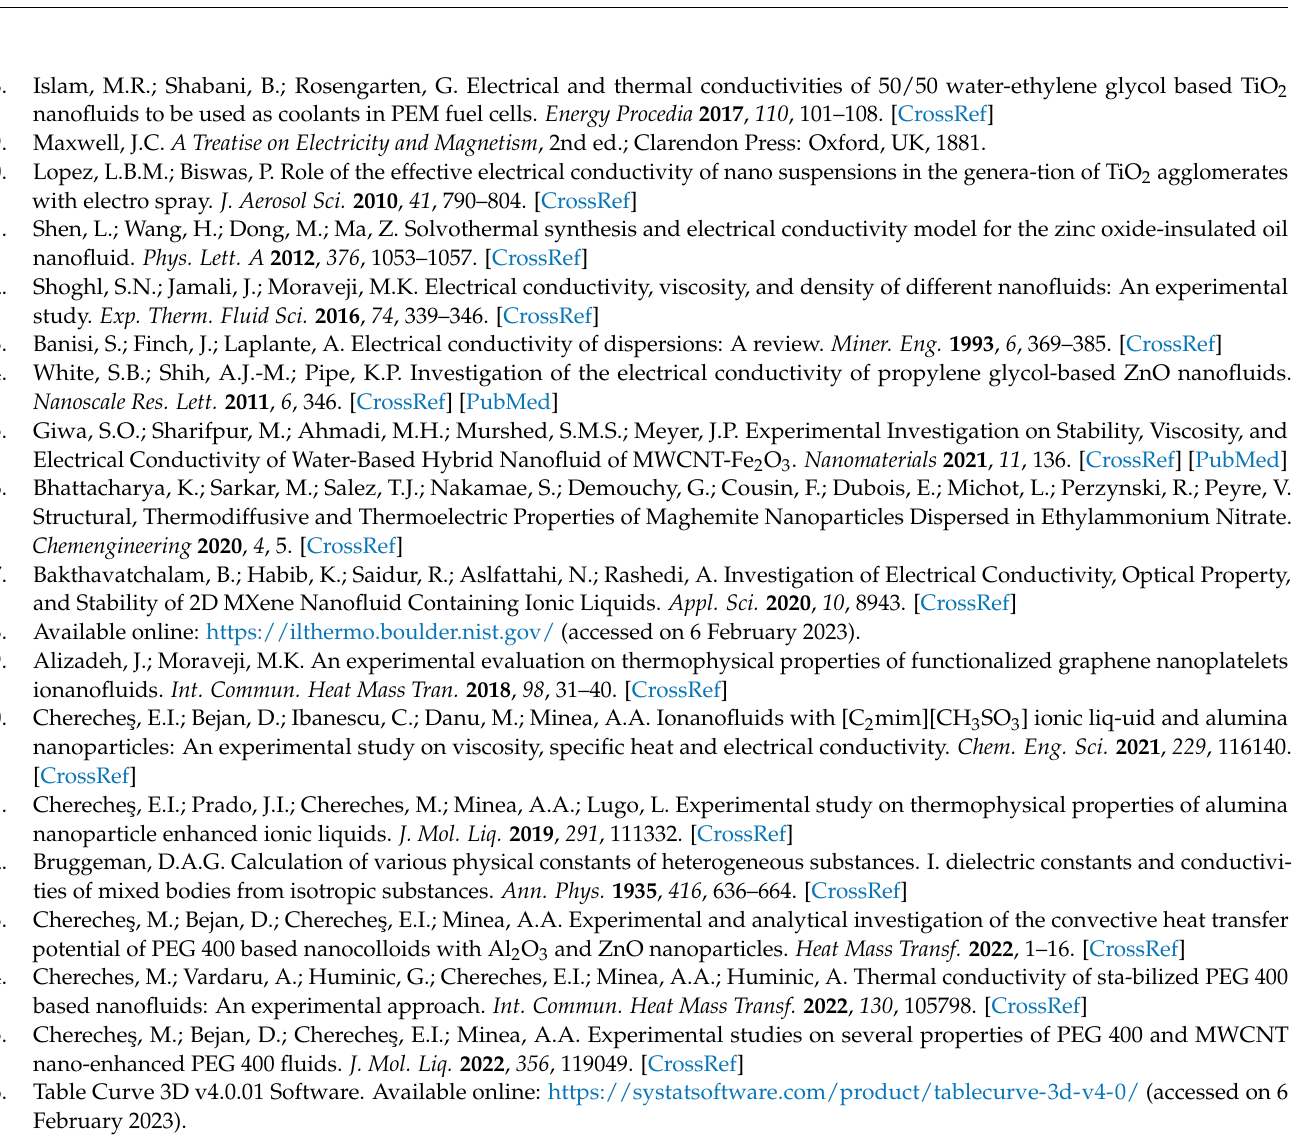
Table Curve 3D v4.0.01 Software. Available online: https://systatsoftware.com/product/tablecurve-3d-v4-0/ (accessed on 6 February